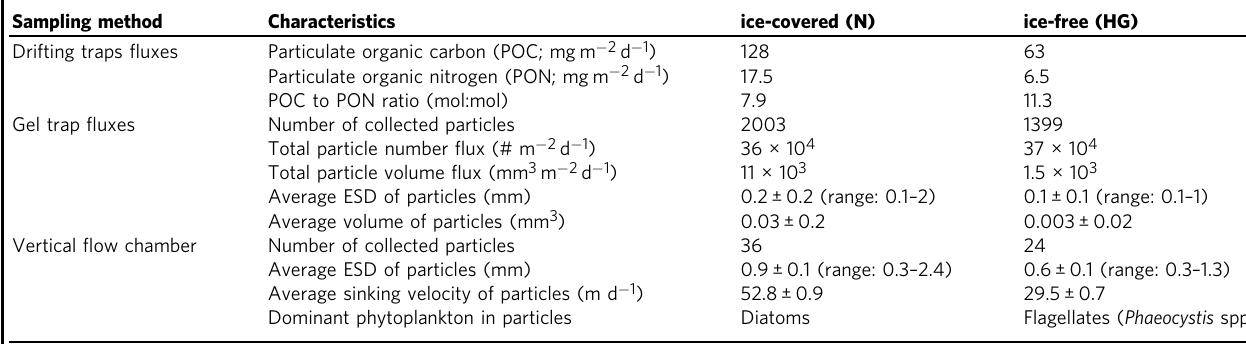
ESD equivalent spherical diameter. The values after ± represent standard